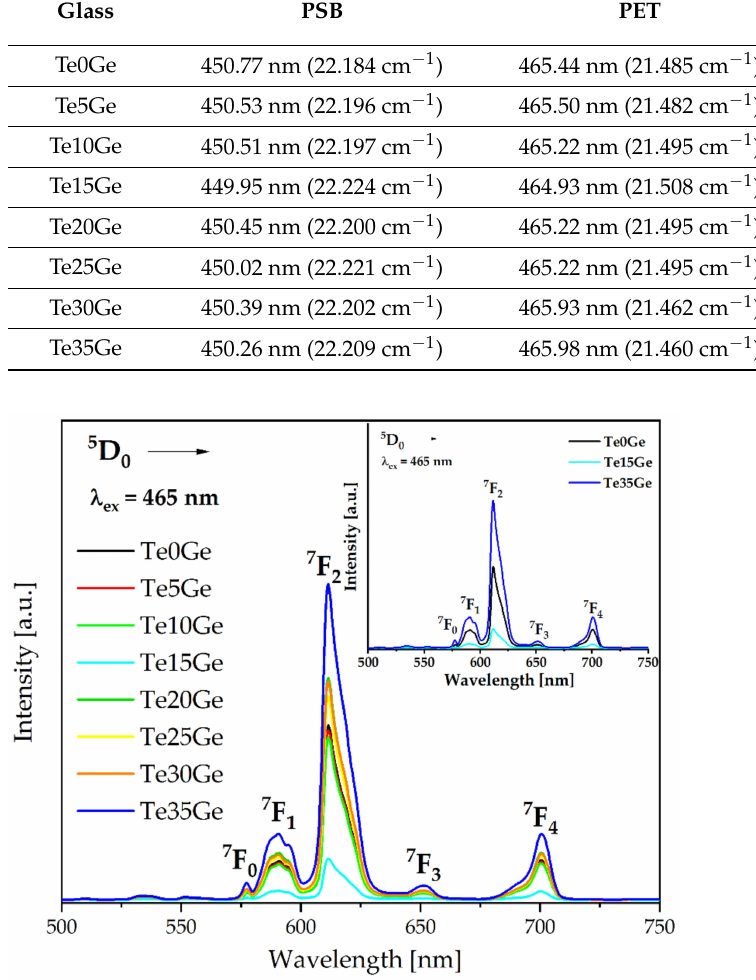
Figure 11. PL spectra of Eu 3+ ions in glasses under 465 nm excitation. The PL spectra selected glasses